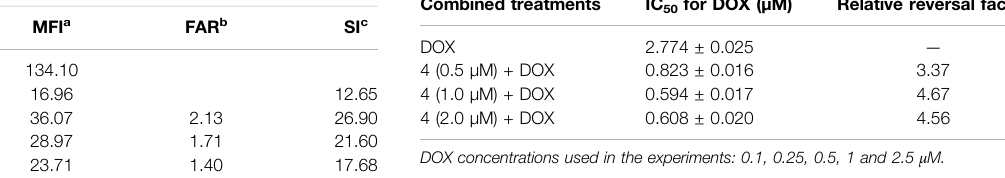
TABLE 1 | P-gp inhibition by derivatives 4, 20, 21, 22, and 23 in the human NSCLC MDR cancer cell line. Treatments